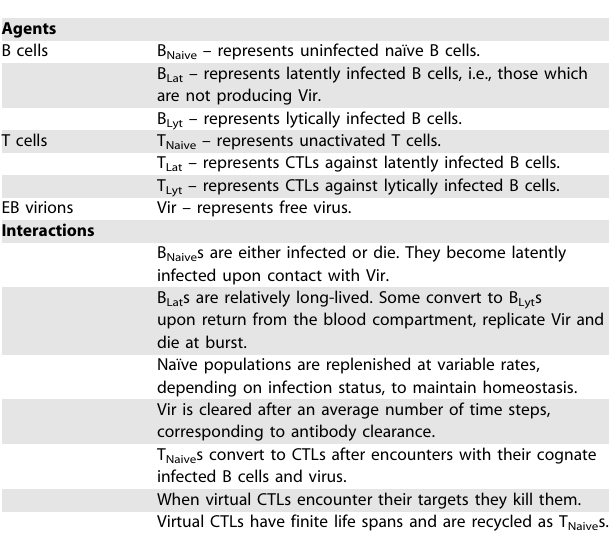
Table 1. A Summary of the Agents and Their Governing Rules Used in This